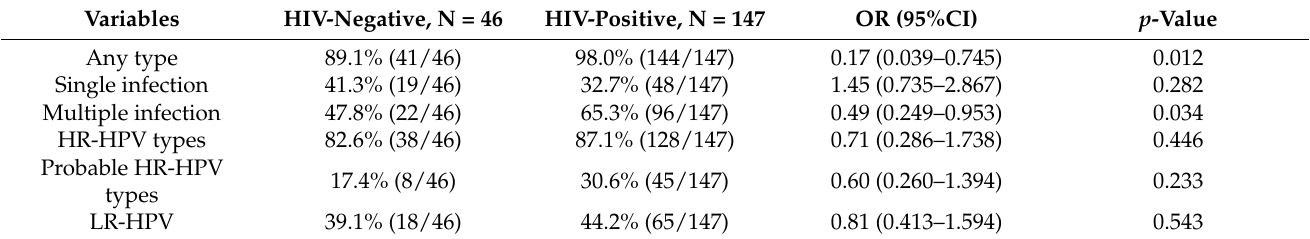
Table 2. Prevalence of HPV infection according to HIV